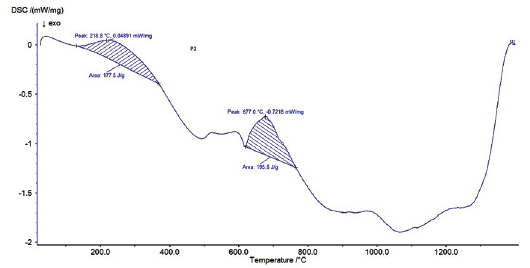
Figure 7: DSC of Pr 3+ (x=10 % and x 1 = 0.5 %) doped borate